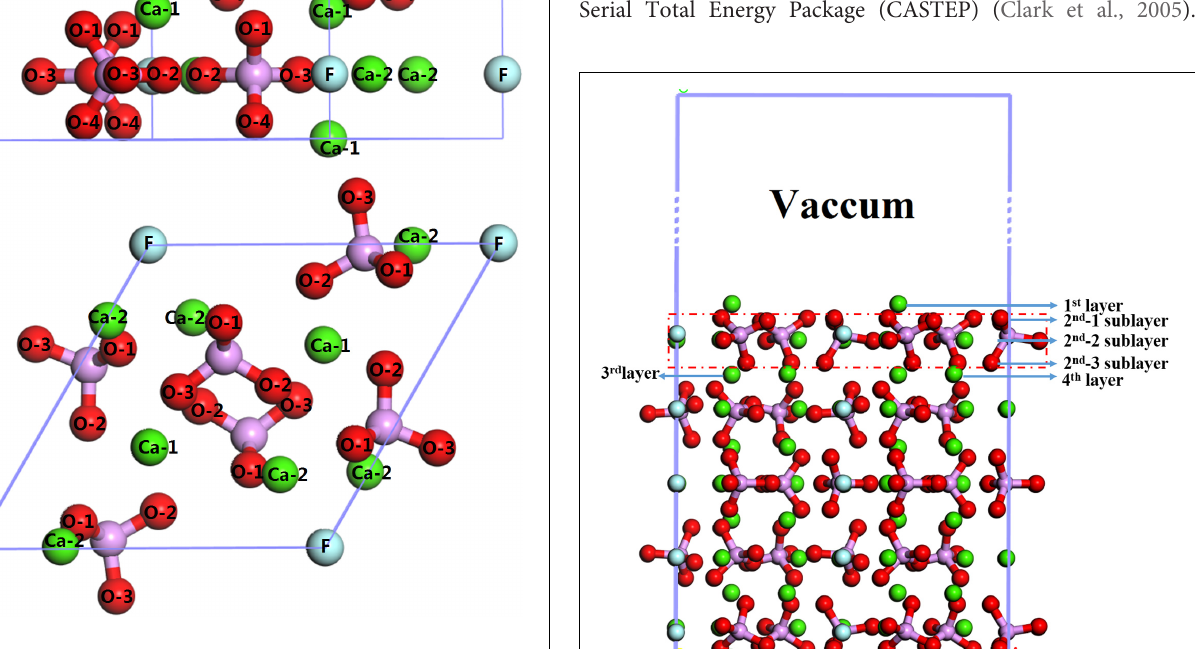
FIGURE 1 | Crystal structure of fluorapatite: (A) side view (perpendicular to the fluorapatite (001) surface); (B) top view (parallel to the fluorapatite (001) surface). FIGURE 2 | Structure of the fluorapatite (001)